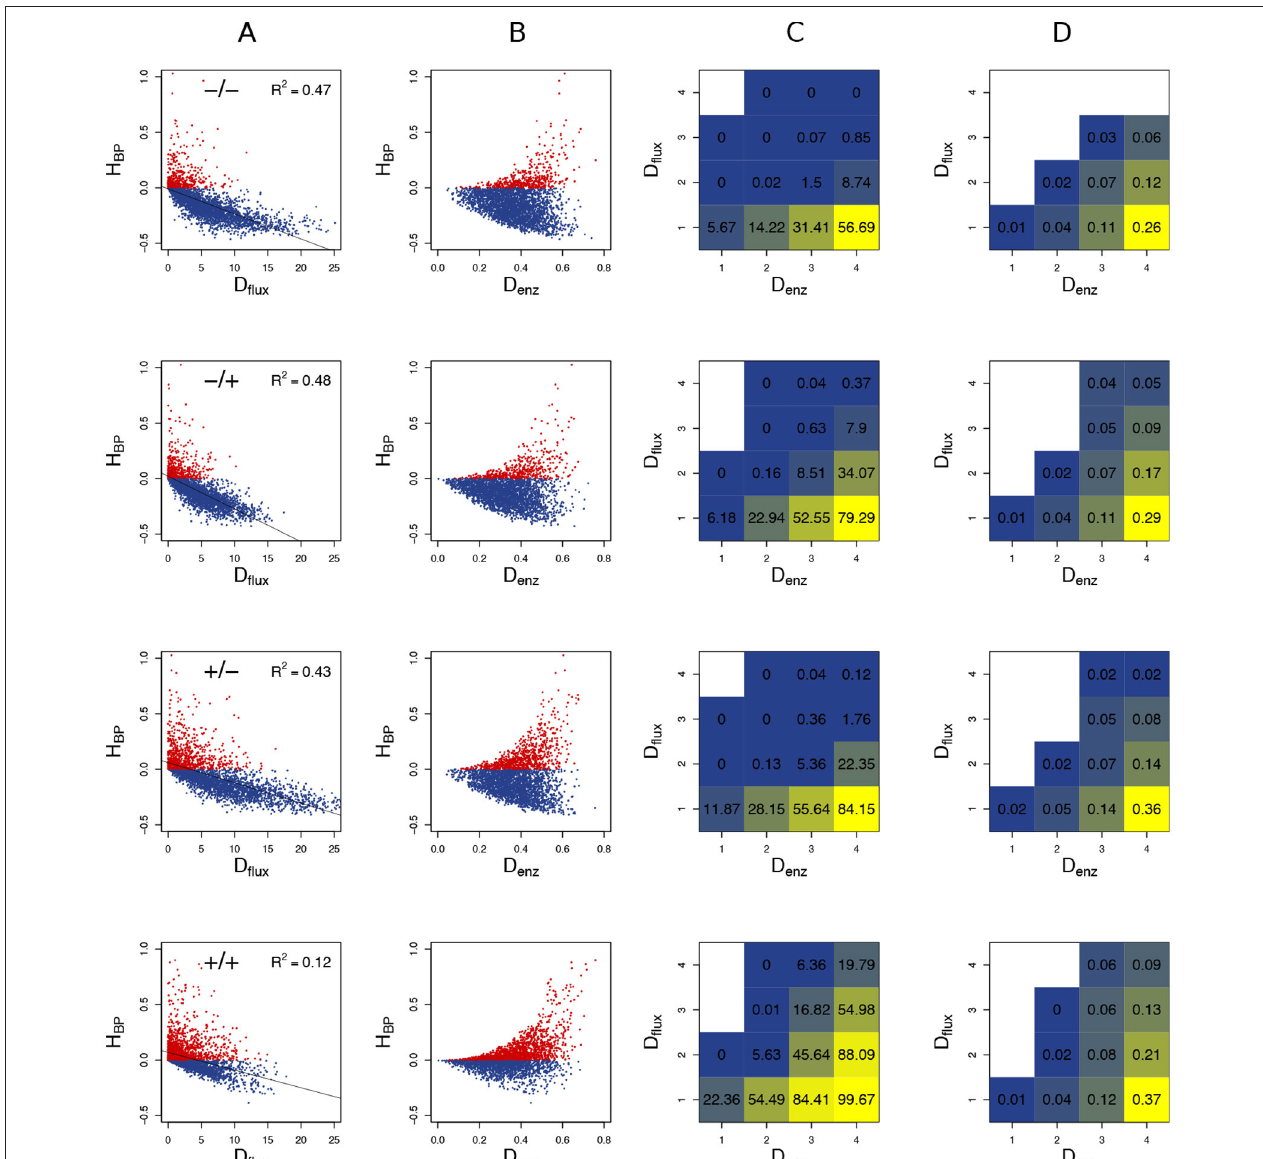
FIGURE 9 | Heterosis predictors. Relationship between H BP and D flux (A) , and between H BP and D enz (B) when c v Square grid of percentages of BPH as a function of D enz (x-axis) and D flux (y-axis). Colors range from blue (minimum % BPH) to yellow (maximum % BPH). Empty squares are white. (D) Same as (C) with H + BP values. The additional white squares correspond to cases where there was no BPH (0 in C ). –/–, –/ have the same meaning as in Figure 7